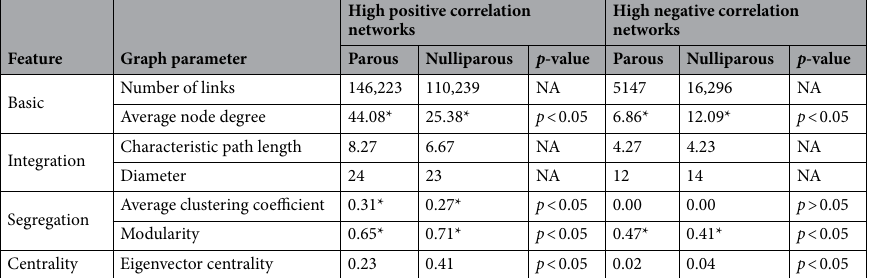
Table 3. Graph-theory parameters associated with the high-correlation specific networks (specific-networks: non-shared nodes). Those values of graph characteristics for which significant differences between nulliparous and parous were found have been marked with an